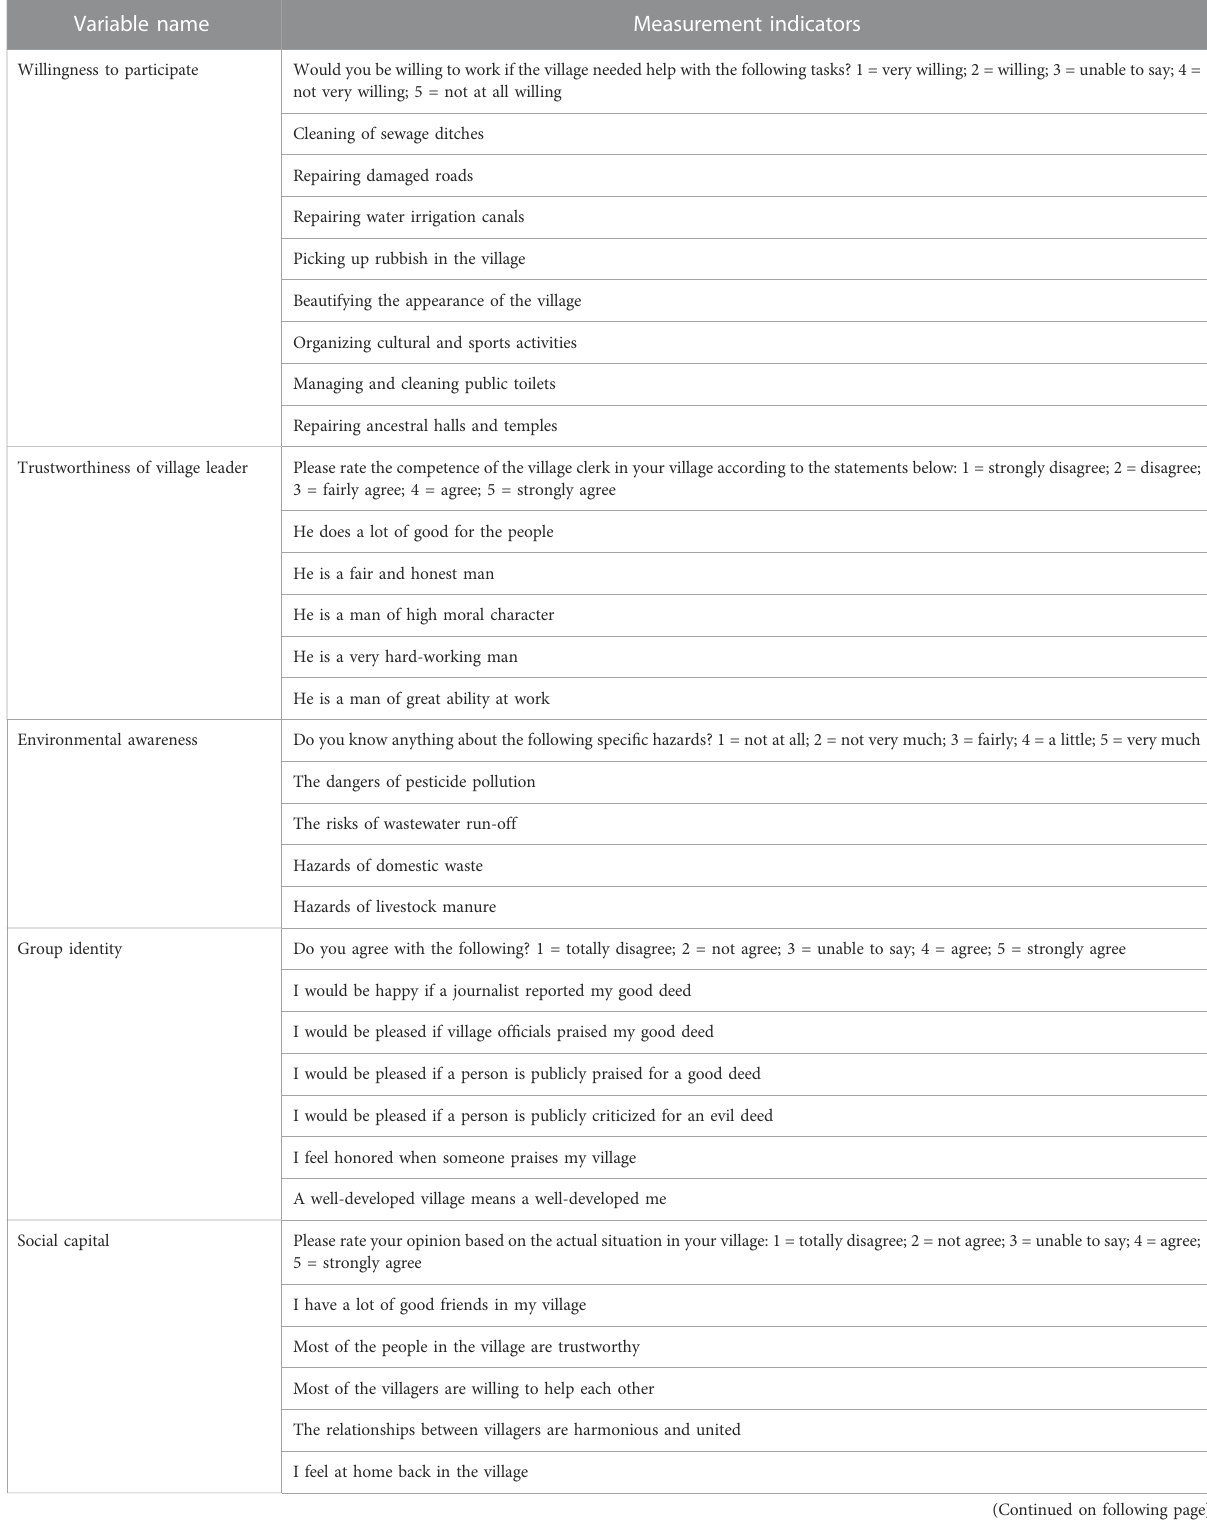
TABLE 1 Indicator system of outcome and condition variables for rural residents ’ willingness to participate in improving their living